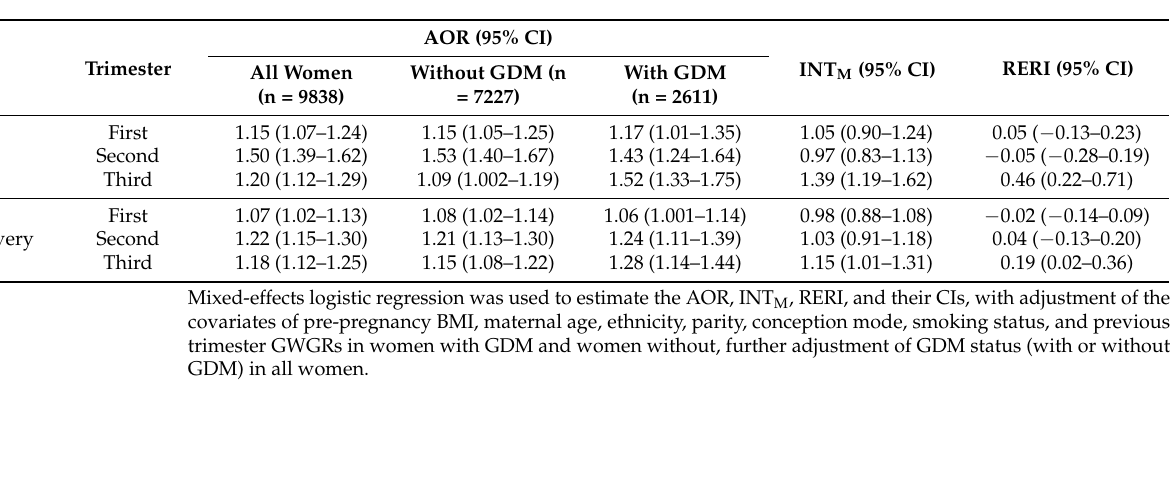
Figure 2. Modifying effect of GDM on association of total GWGR with perinatal outcomes by pre-pregnancy BMI categories: ( A1 ) multiplicative interaction between total GWGR and GDM in underweight women; ( A2 ) additive interaction in underweight women; ( B1 ) multiplicative interaction in normal-weight women; ( B2 ) additive interaction in normal-weight women; ( C1 ) multiplicative interaction in overweight/obese women; ( C2 ) additive interaction in overweight/obese women. Mixed-effects logistic regression was used to estimate the INT M and RERI, with adjustment of the covariates of maternal age, ethnicity, parity, conception mode, and smoking status. The parts of the confidence interval exceeding 0 to 3 for INT M and − 3 to 3 for RERI are not shown in the figure. Table 3. Modifying effect of GDM on association of trimester-specific GWGR with LGA and cesarean